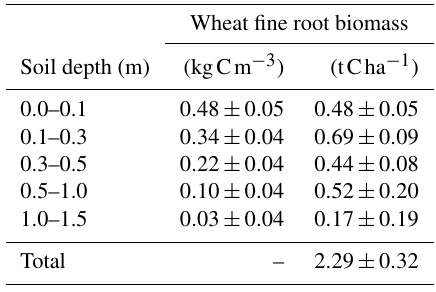
Table 3. Wheat fine root biomass in the agricultural control plot in 2012.